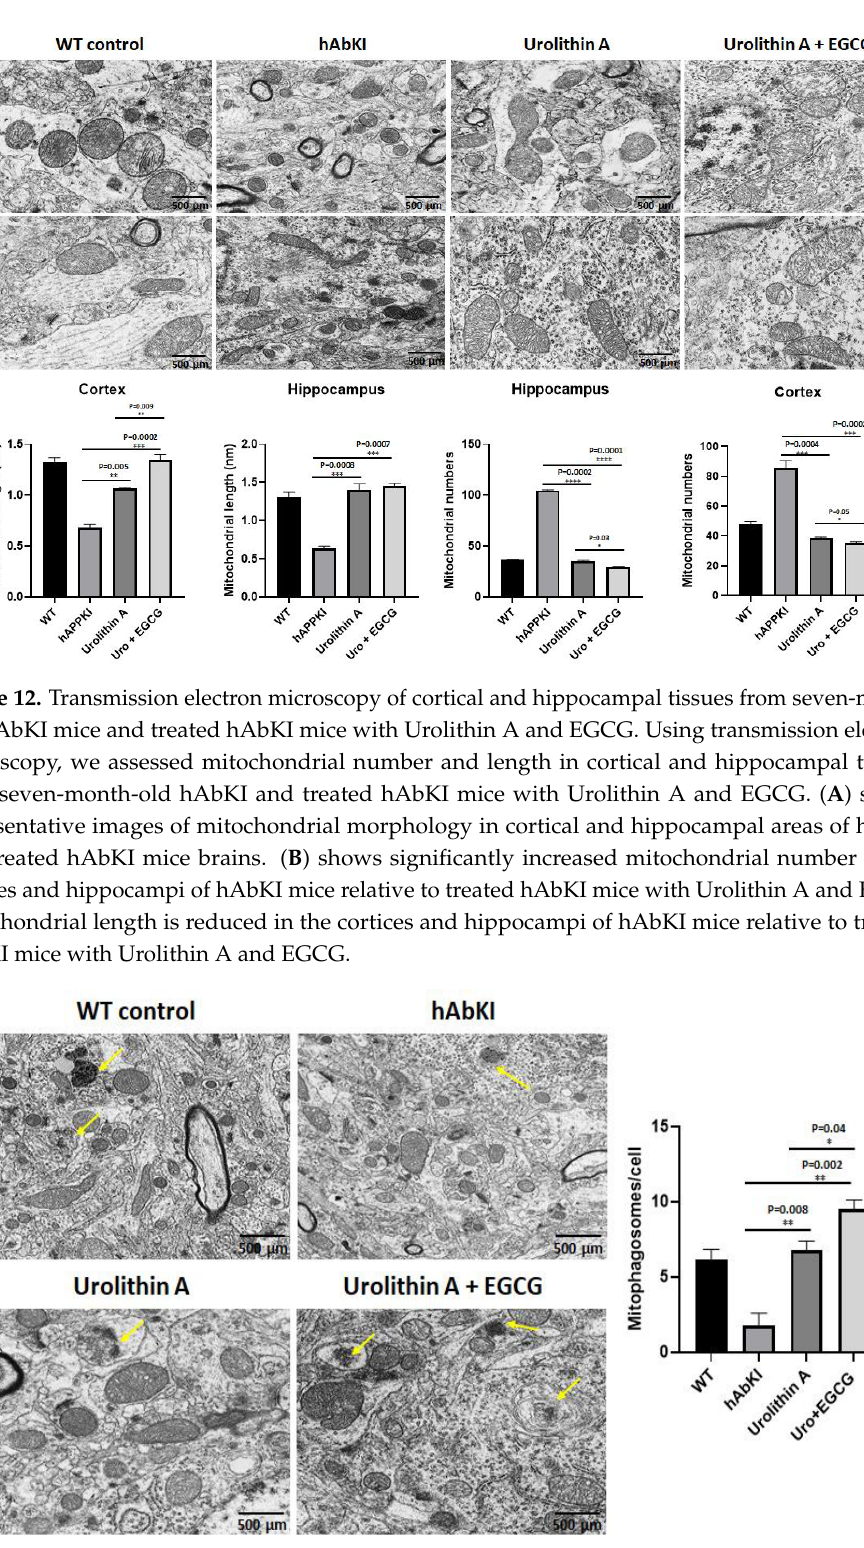
Figure 13. Mitophagosoma formations assessment using transmission electron microscopy in hip- pocampal tissues from urolithin A and urolithin A+EGCG-treated hAbKI mice and untreated hAbKI mice as controls. Mitophagosomal formations were increased in urolithin and combined treatment of urolithin A+EGCG in hAbKI mice. Mitophagosomal formations were increased for combined treatment of urolithin A+EGCG compared to urolithin A-treated hAbKI